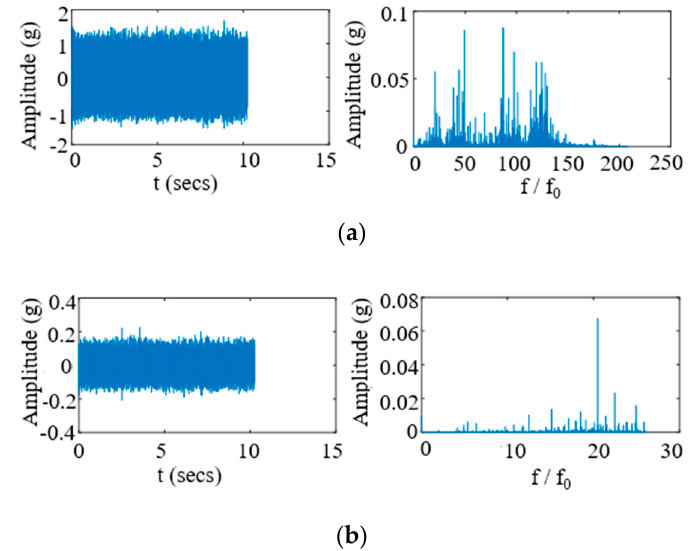
Figure 6. Comparison of signals as well as the frequency results before and after downsampling: ( a ) Original signal and frequency results of FFT; ( b ) Downsampled signal and frequency results of FFT.